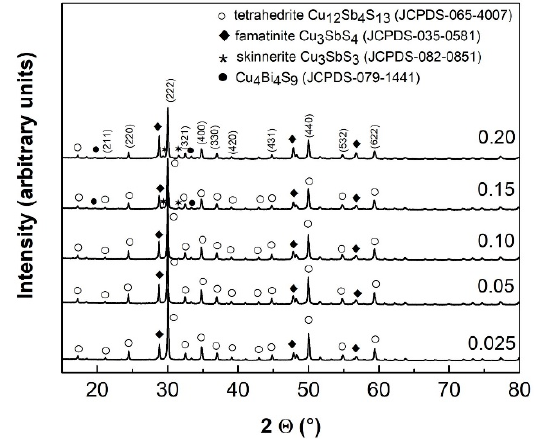
Figure 1. XRD patterns of sintered samples with nominal Bi content, X Bi = 0.025, 0.05, 0.10, 0.15 and 0.20. and